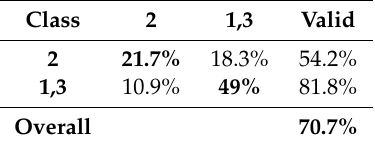
Table 8. Results from the test part of the dataset from the CNN for vehicle binary classification. Final results for each class on the main diagonal in confusion matrix (highlighted as bold) are